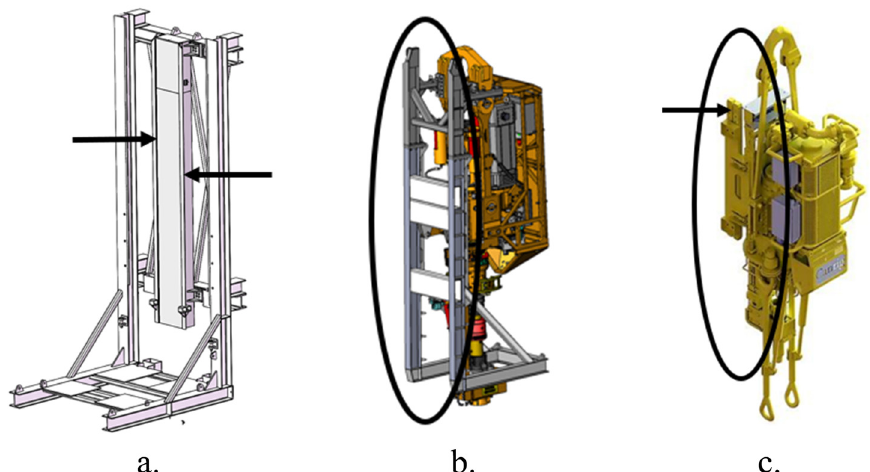
Figure 1: Top drive test stand and various top drives that need to be accommodated: ( a ) Canrig test stand, ( b ) Tesco EX300, and ( c ) Canrig top drive.